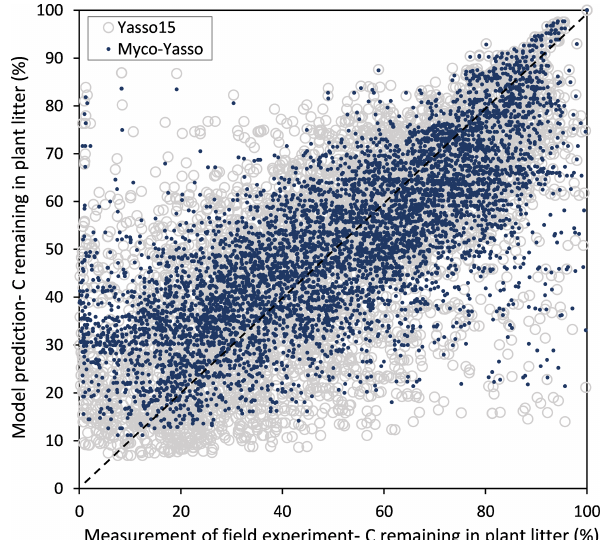
Figure C1. Scatter plot of predictions for C loss from plant litter made by the original Yasso15 model (grey circles) and predictions made by the Myco-Yasso model (blue dots) compared to experi- mental measurements.